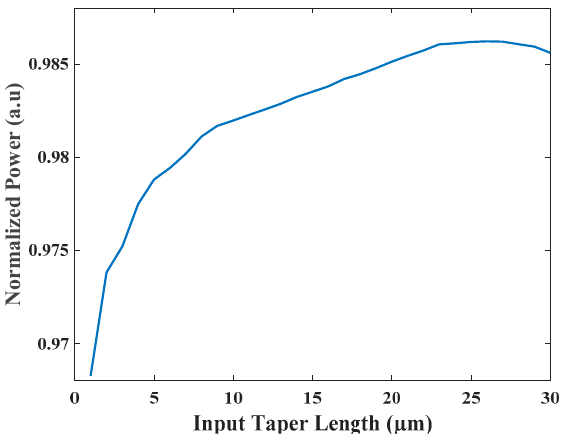
Figure 6. Normalized power as a function of the taper length.